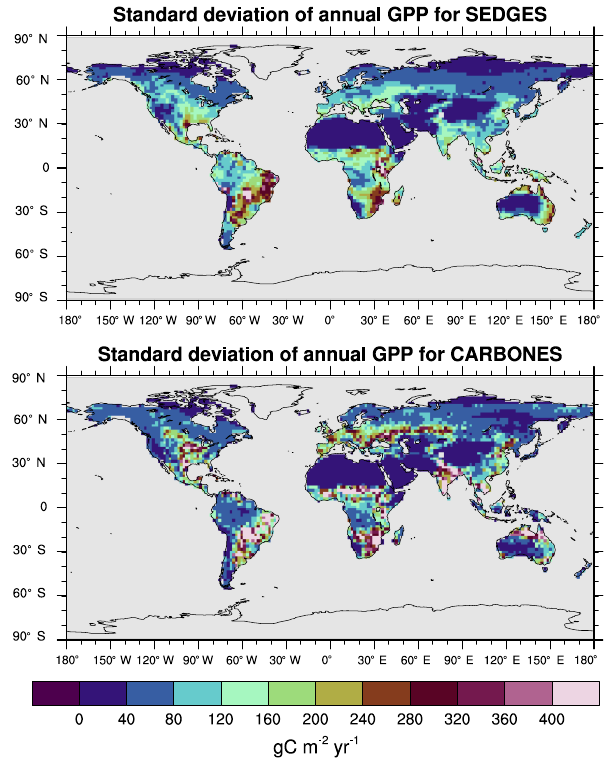
Figure 9. Interannual variability in GPP for SEDGES and the CAR- BONES reference dataset for the 1990–2009